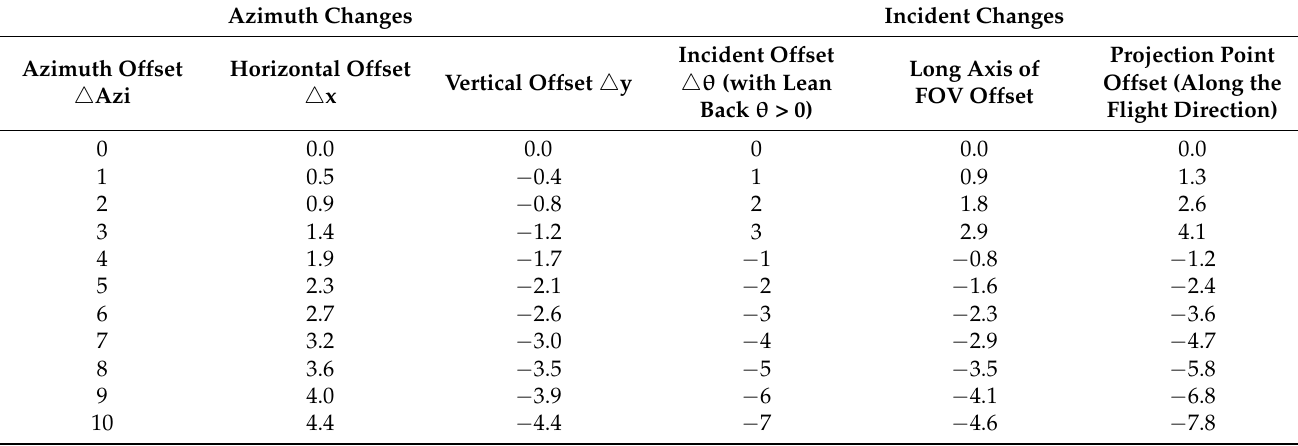
Table 5. The influence of small variation in the incident angle and azimuth angle on the projection point and